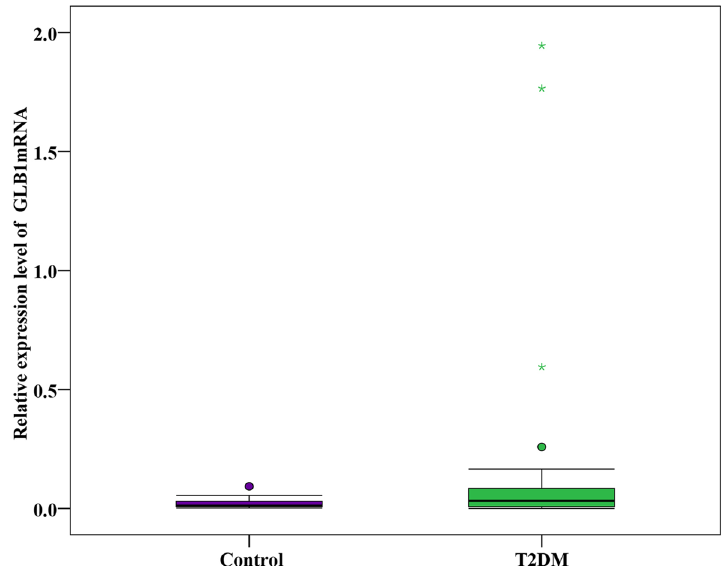
Fig. 3 Box plot showing the comparison between the two studied groups according to the relative expression of GLB1 mRNA ( p